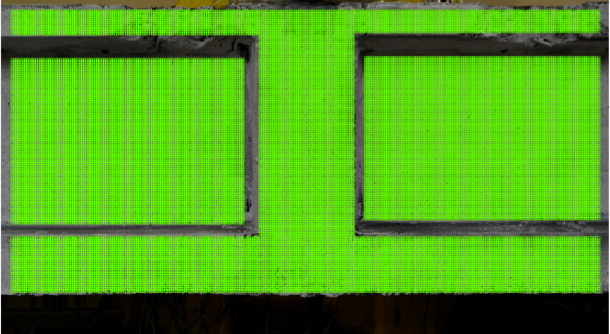
Figure 11. Grid of subsets placed on the surface of the tested crane runway